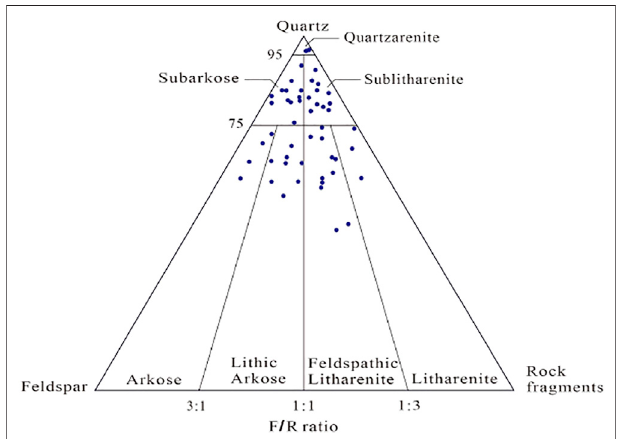
FIGURE 2 | Ternary diagram of the Upper Paleozoic sandstone in the Dongpu Depression (after Folk, 1968).